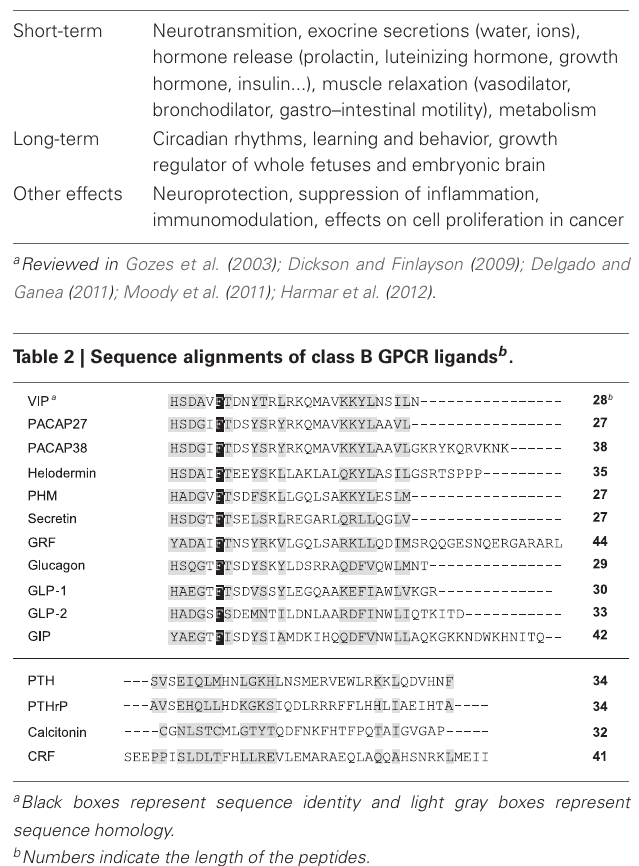
Table 1 | Major physiological and pathophysiological actions of VIP a .